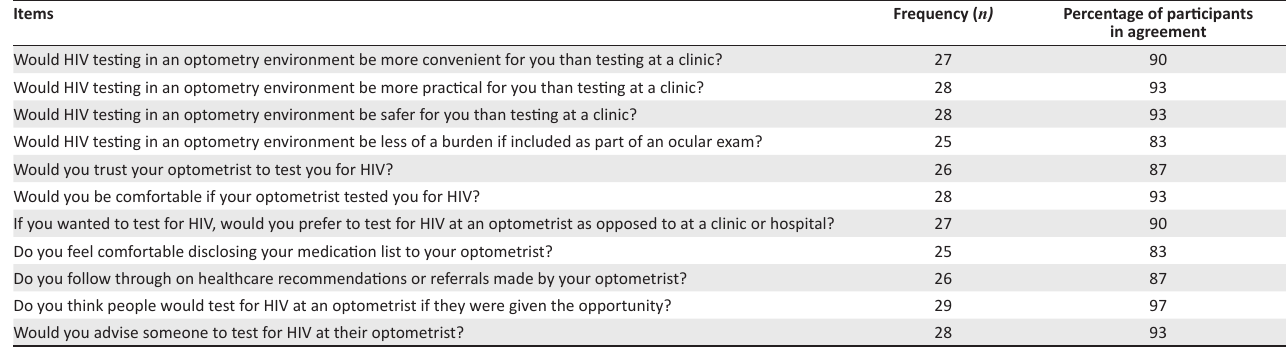
TABLE 1: Items included to explore if patients presenting to optometry practices perceive this environment as a potential contributor to capacity building for human immunodeficiency virus testing and counselling services.